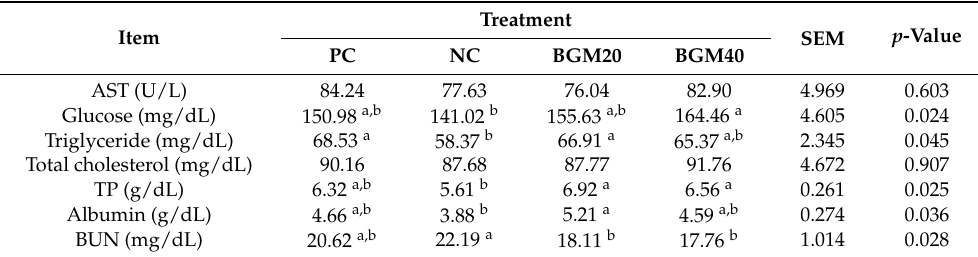
Table 4. Effect of dietary BGM with combined enzymes inclusion on blood metabolites of growing pigs 1 .